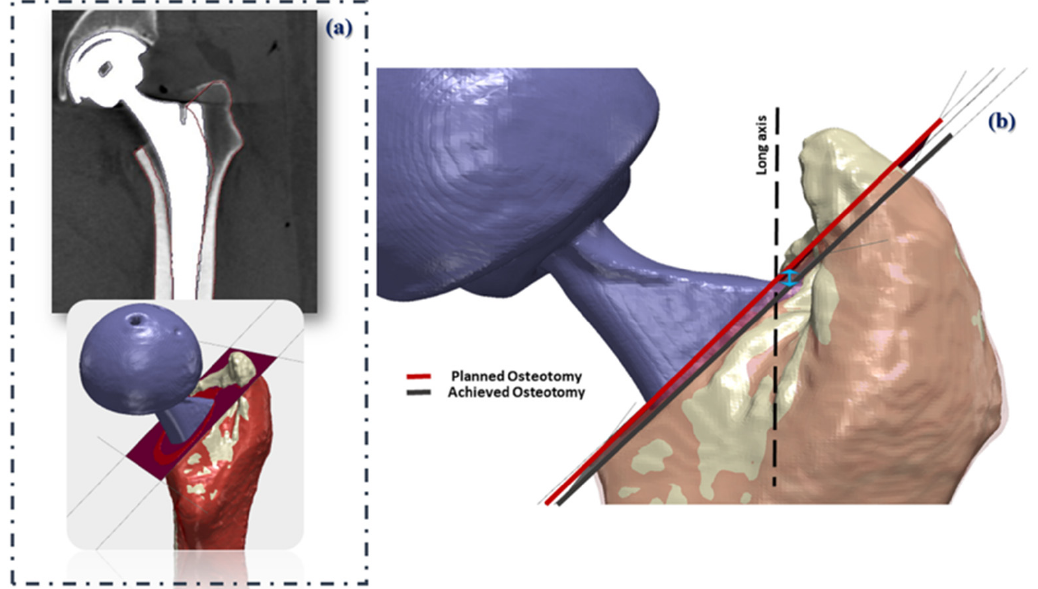
Figure 4. ( a ) The surgical plan in red colour is registered to the post-operative CT scan (model in white colour); ( b ) The relative vertical discrepancy between the achieved and planned osteotomy planes is quantified (light blue arrow).